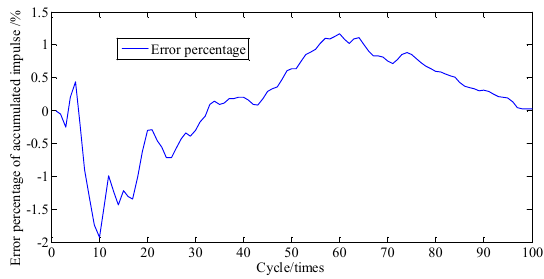
Figure 10. Error percentage of piston impulse accumulated.